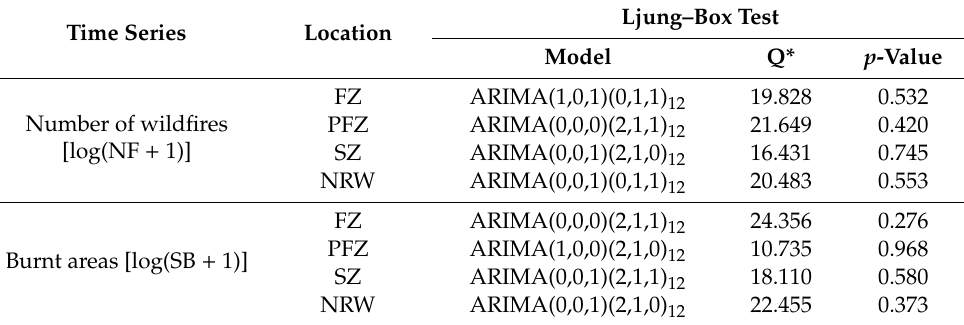
Table 3. Residual analysis of wildfire time series by ecoregion.